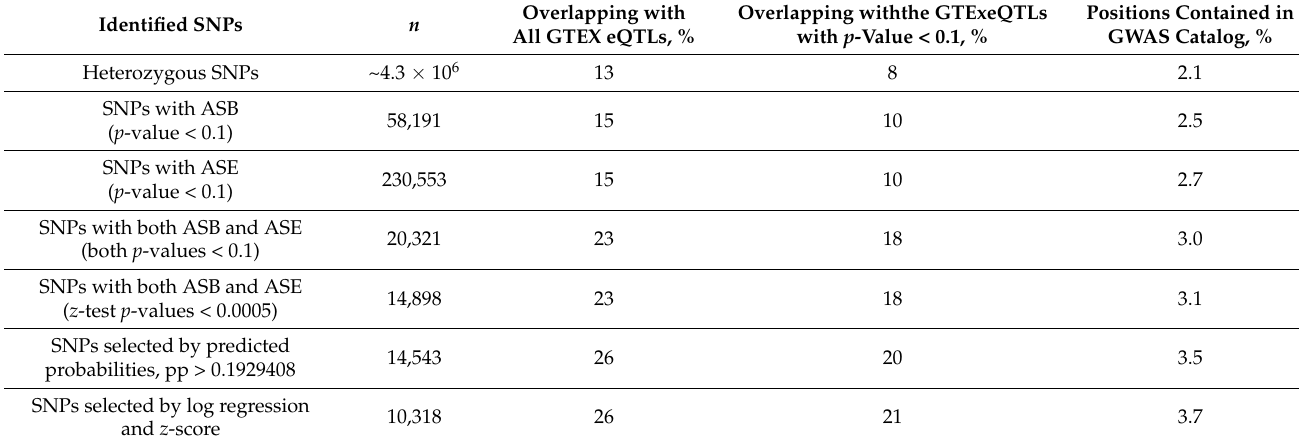
Table 2. Gradual enrichment of SNP sets with GTExeQTLs and GWAS associations. ASB, allele-specific binding bias; ASE:allele-specific expression bias; eQTLs:GTEx expression quantitative trait loci; GWAS:all available GWAS-derived SNP-